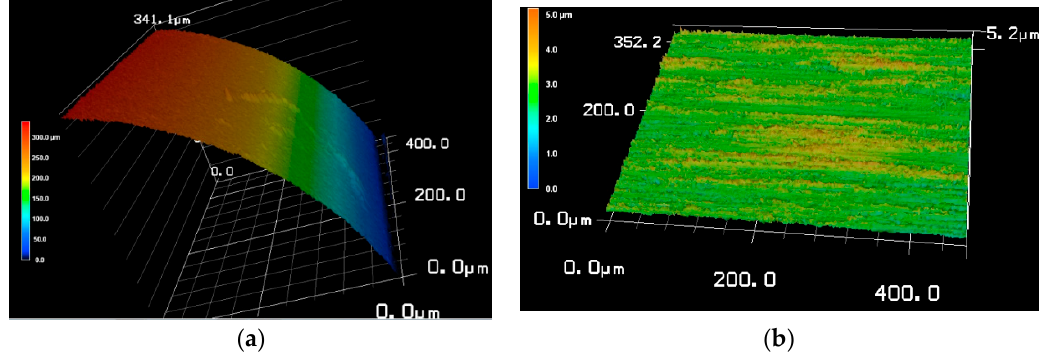
Figure 14. Surface roughness: initial wire surface ( a ), and rolled wire surface ( b ).